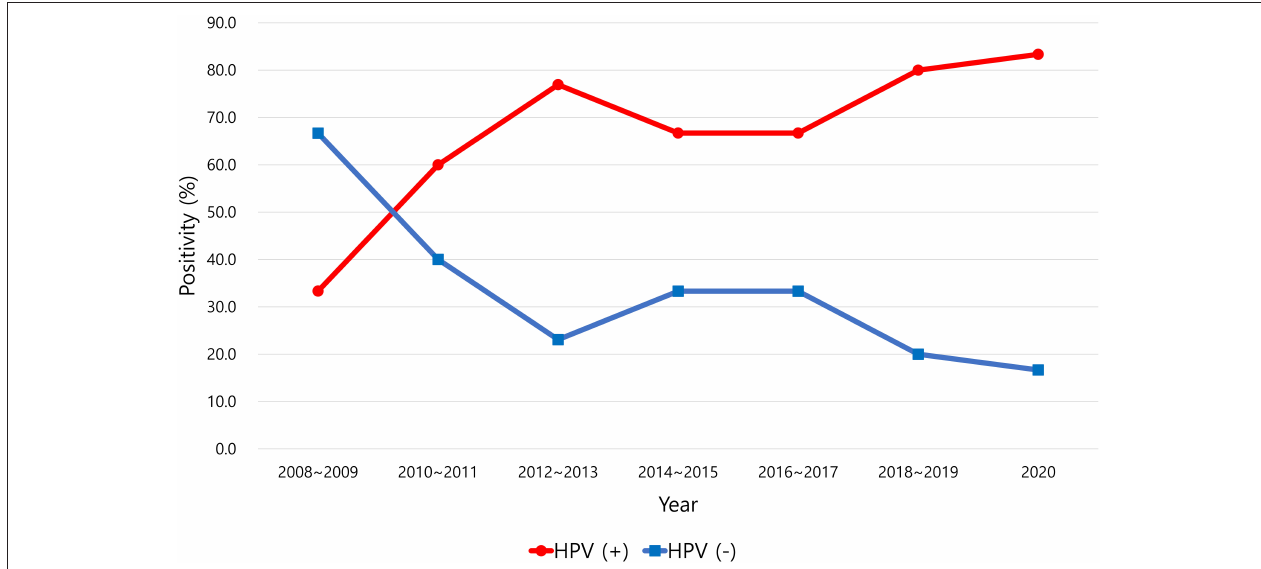
FIGURE 1 | Positive rate of human papillomavirus (HPV) in oropharyngeal squamous cell carcinoma.